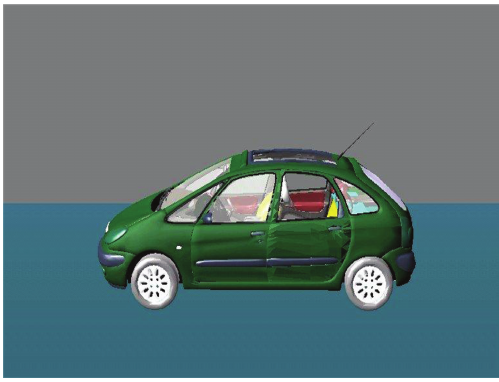
Figure 1: Prototype VE for decoupled